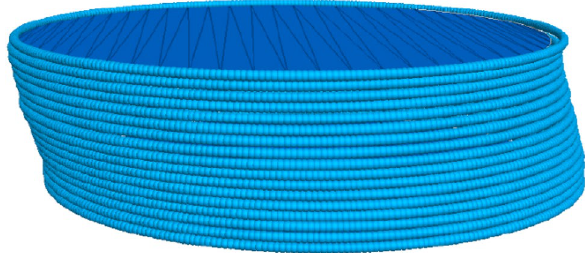
Figure 1. Boundary condition of the DEM model.